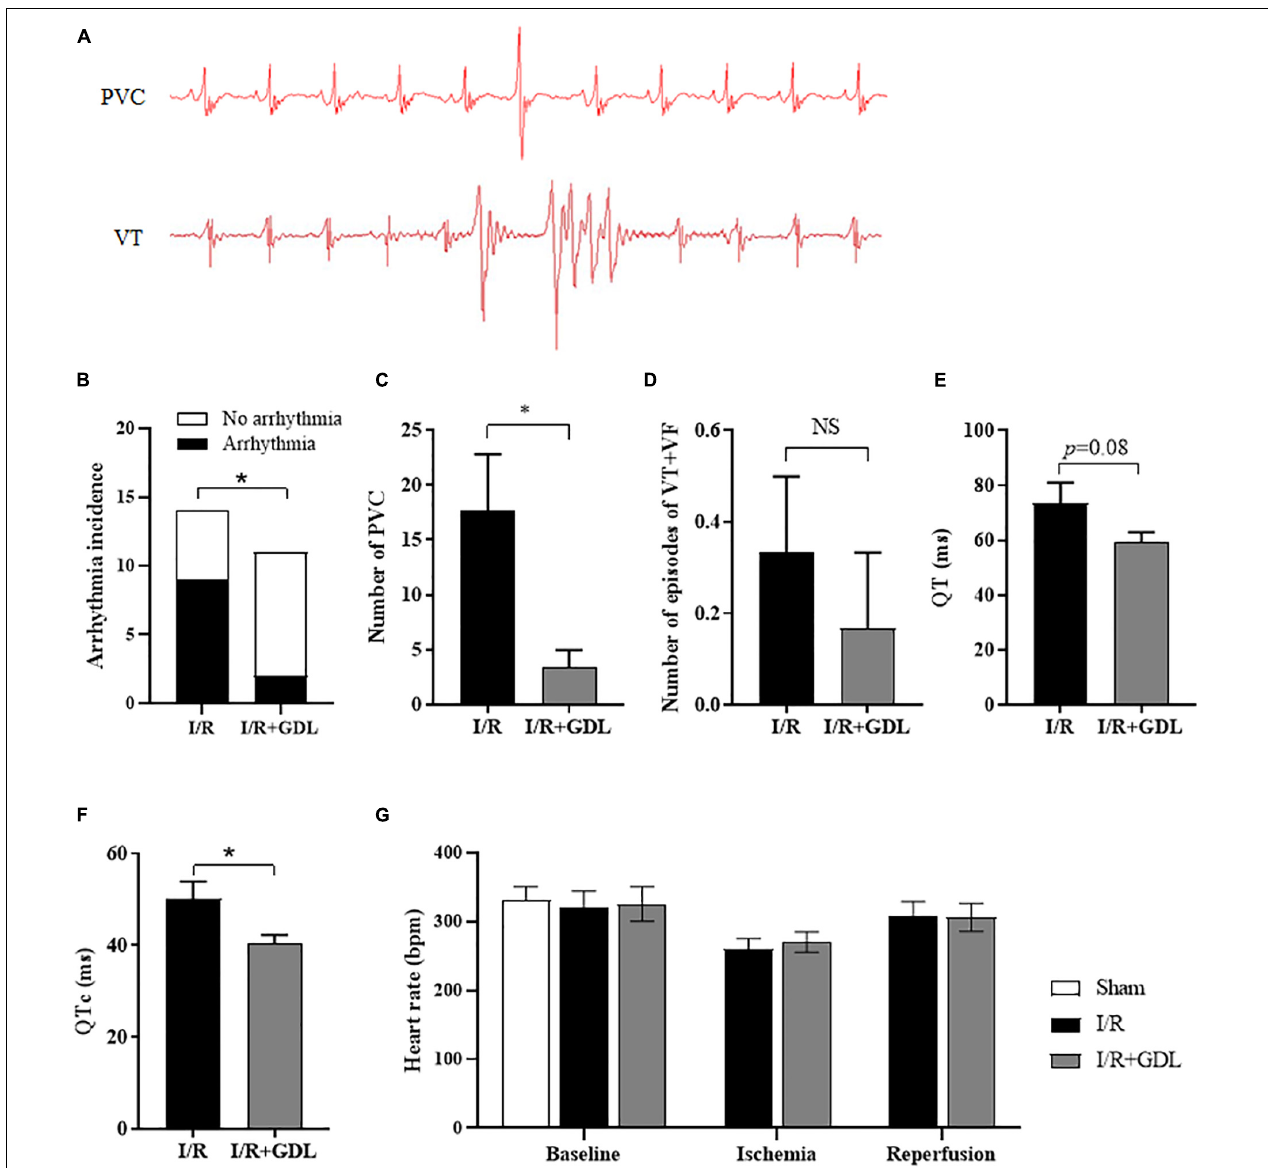
FIGURE 2 | D-glucono-1,5-lactone reduced reperfusion-induced arrhythmias. (A) Representative examples of different ventricular arrhythmias (PVC and VT) during 30 min post-reperfusion. Arrhythmia incidence (B) , number of PVC (C) , number of VT + VF (D) , QT duration (E) and corrected QT (F) in I/R-injured mice in the presence or absence of GDL treatment ( n = 6). Heart rate (G) of all sections, including baseline, ischemia and reperfusion ( n = 6). * P < 0.05 between indicated